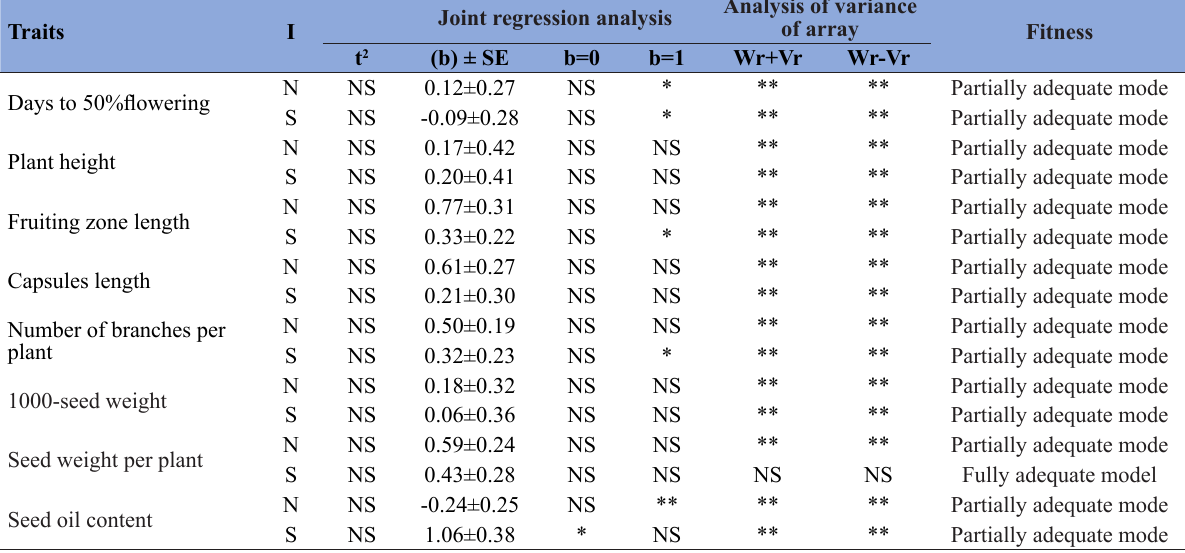
Table 11. Adequacy test of the data for additive-dominance model for all studied traits under normal irrigation (N) and water stress conditions (S) in 2019